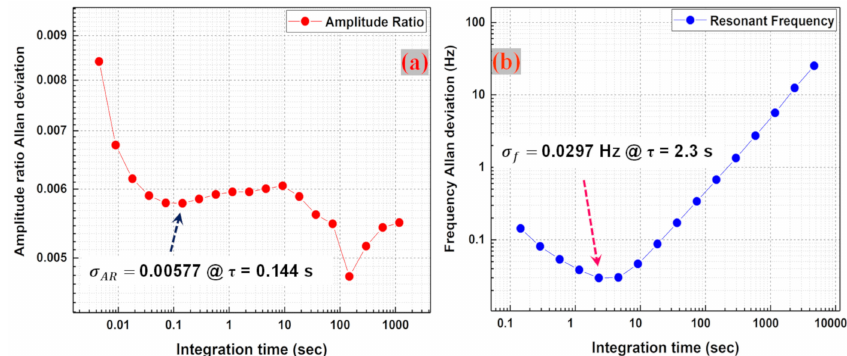
Figure 11. ( a ) Measured amplitude ratio Allan deviation of the coupled MEMS resonators. Best amplitude ratio stability of 0.00577 occurs at τ = 0.144 s, ( b ) Measured frequency Allan deviation of the coupled MEMS resonators. Best frequency stability of 0.0297 Hz occurs at τ = 2.3